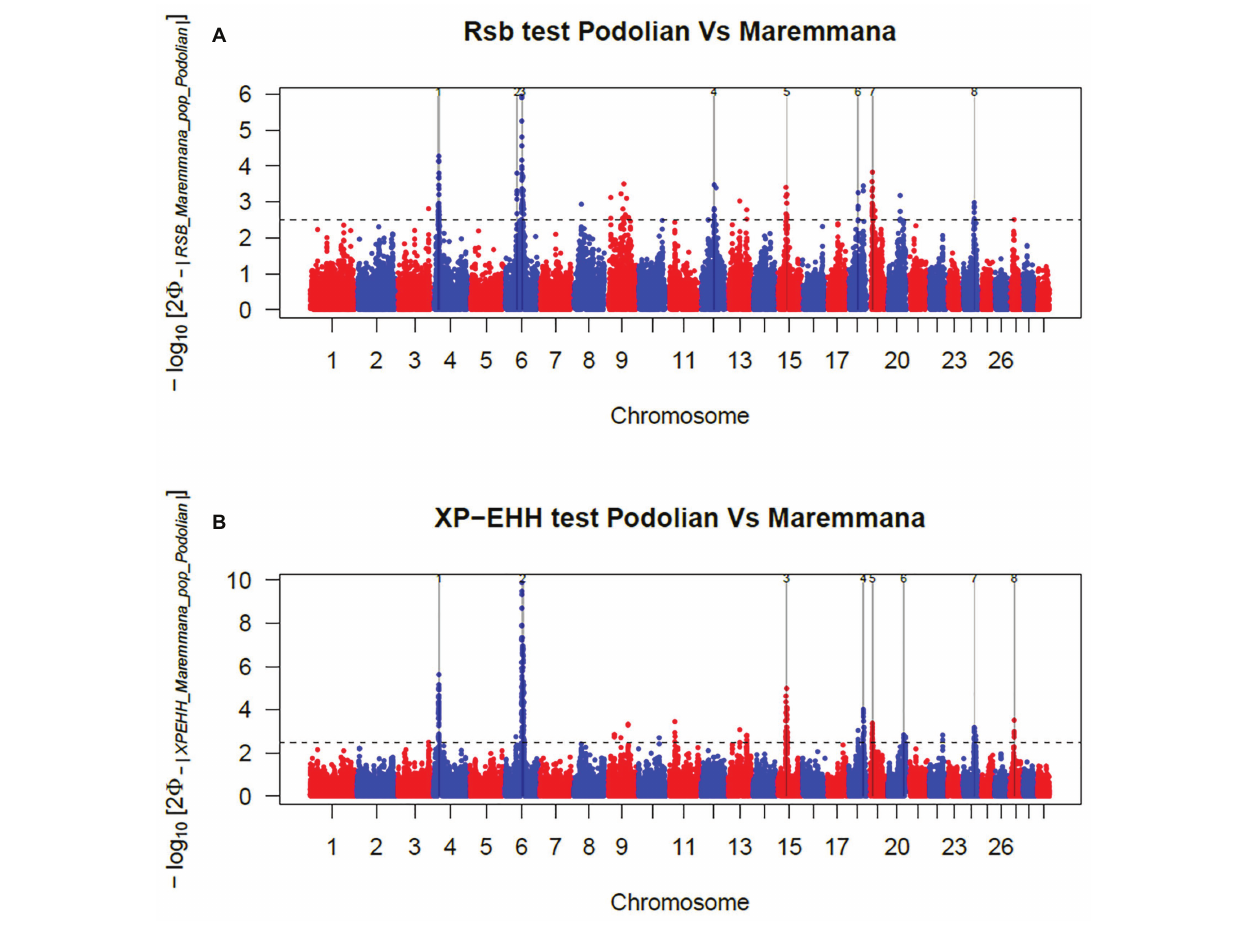
FIGURE 4 | Manhattan plots showing the results of (A) Rsb and (B) cross-population extended haplotype homozygosity ( XP-EHH ) test analyses in the comparison between Maremmana and Italian Podolian-derived breeds. Horizontal dashed lines mark the significance threshold applied to detect the outlier SNPs − log10 ( p - value) =